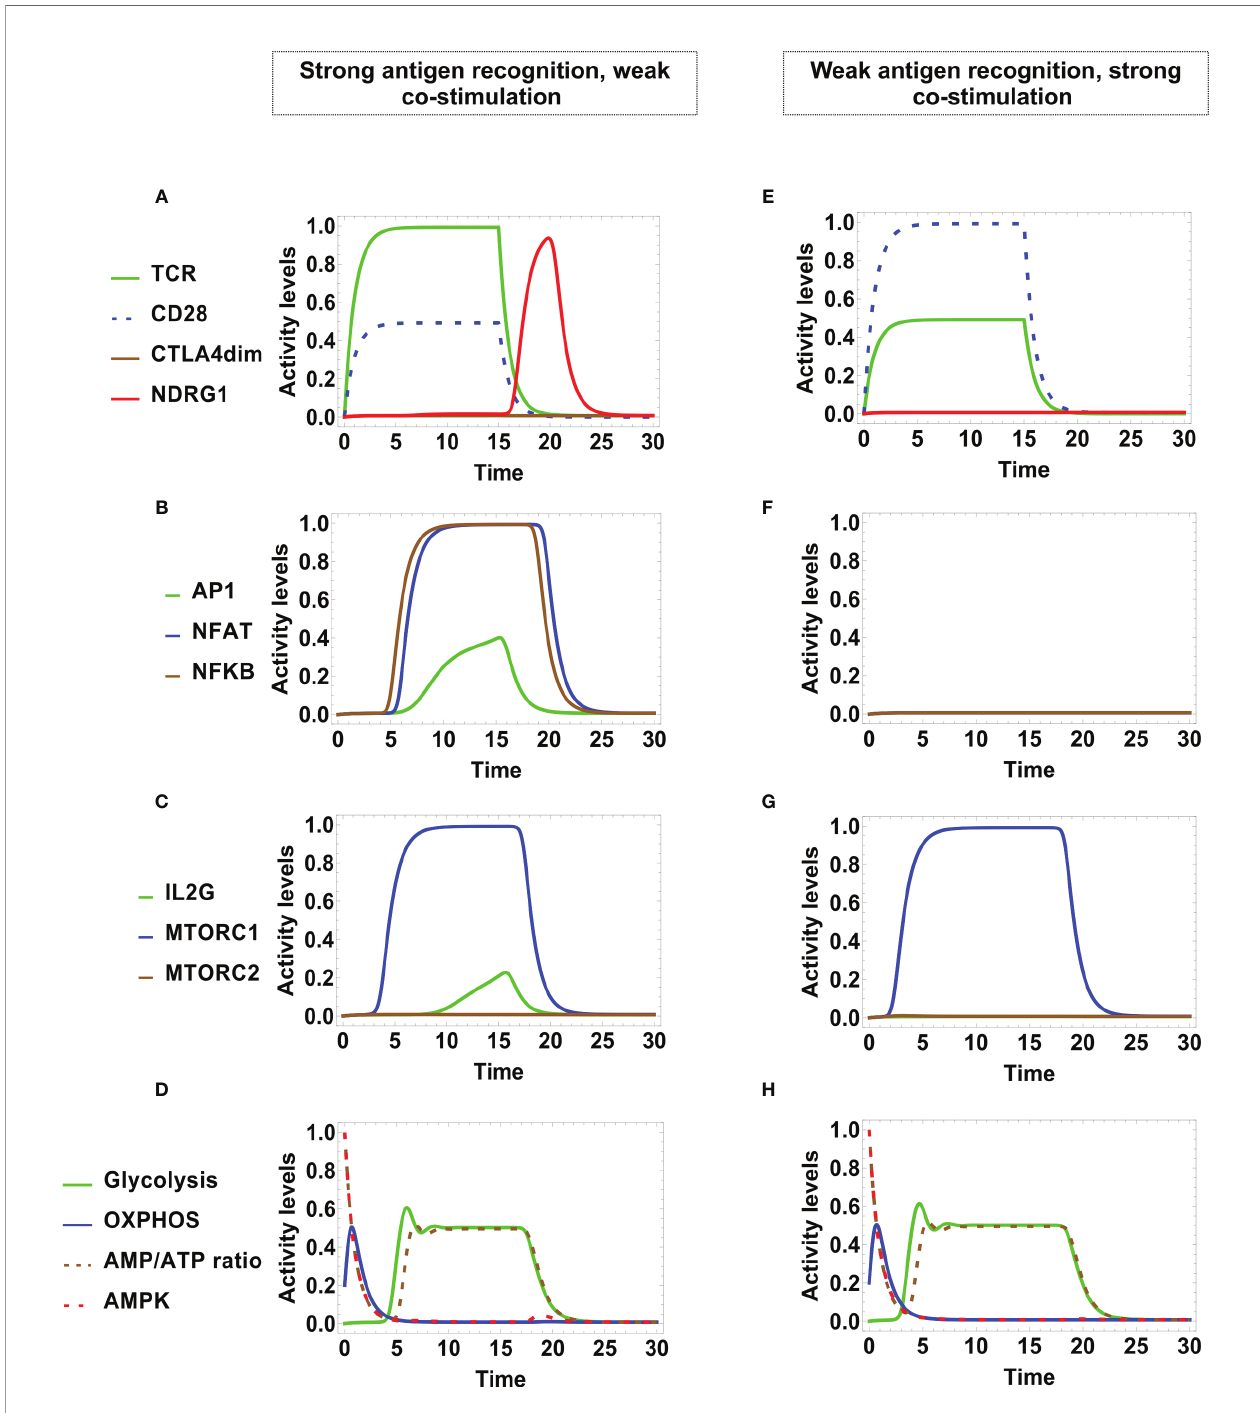
FIGURE 6 | Dynamics of transcription factors and metabolism after incomplete stimulation during an activation time t MHC / A = t CD 8086 = 15 units. Left panel: Anergy is induced by strong TCR stimulation and weak CD28 co-stimulation (A MHC / A = 1 and A CD 8086 = 0.5). (A) TCR and CD28 are transiently activated, decaying both at time t MHC / A = t CD 8086 . At this time the anergy factor NDRG1 is temporarily expressed. (B) NFAT, NF k B, and AP-1 are down-regulated by the inhibitory action of NDRG1. (C) Similarly, mTORC1 and IL2 are only transiently expressed. (D) The metabolic pro fi le is similar to that associated to regulated activation induced by CTLA-4 ( Figure 4H ). Right panel: Anergy is induced by weak TCR stimulation and strong CD28 co-stimulation (A MHC / A = 0.5 and A CD 8086 = 1. (E) TCR and CD28 show full and low -level activation, respectively, both decaying at time t MHC / A = t CD 8086 ; however, the anergy factor NDRG1 remains unexpressed. (F) . NFAT, NF k B, and AP-1 are unexpressed. (G) mTORC1 is fully activated, but decays along the antigenic stimulation. (H) The metabolic pro fi le is similar to that associated to regulated activation induced by CTLA-4 ( Figure 4H